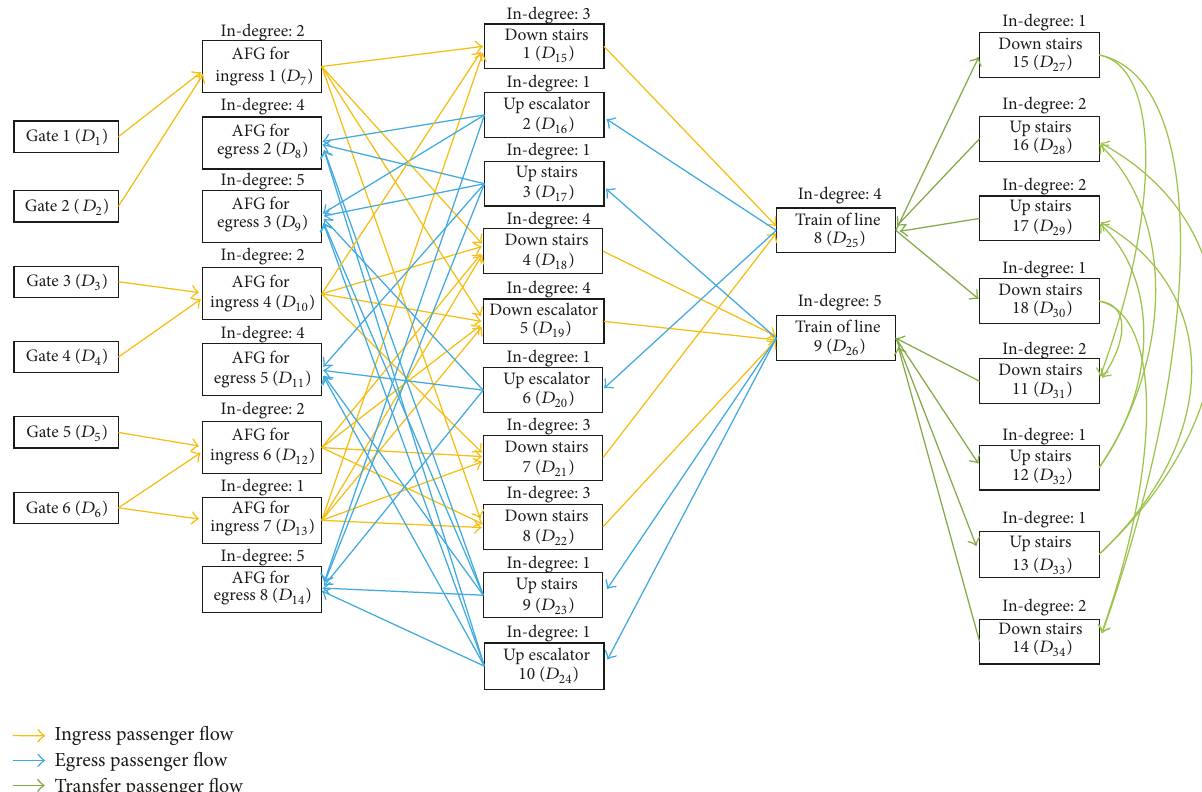
Figure 5: The association network of facilities in LJB